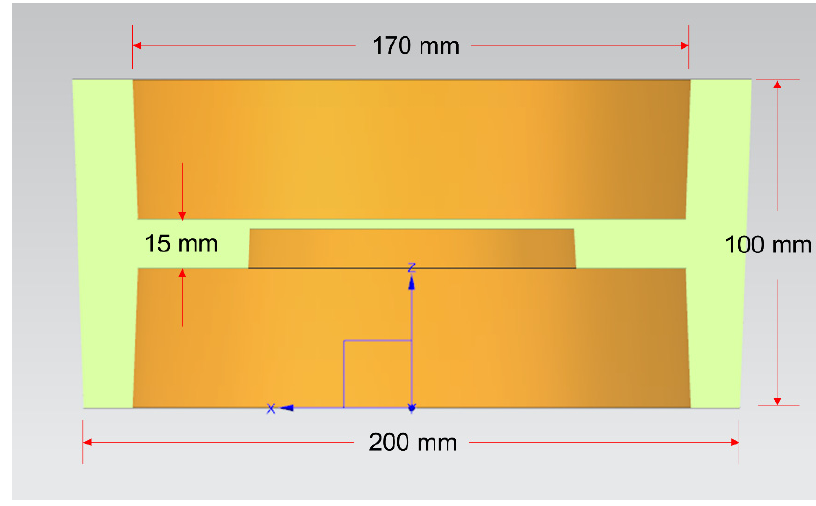
Figure 3. Schematic diagram of the size of the part blank profile.